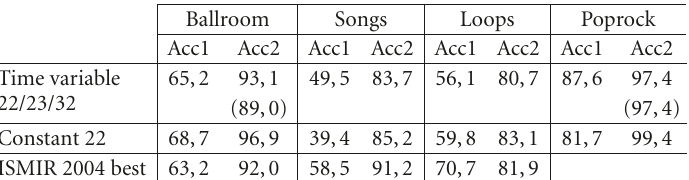
Table 2: Results of the tempo estimation